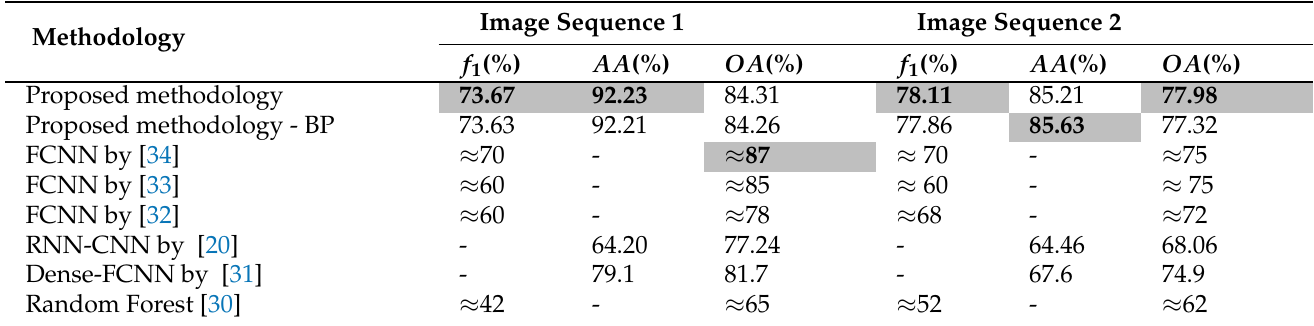
Table 6. Overall accuracy from Campo Verde database and comparison with the state-of-the-art.The highest values achieved for each measurement are highlighted.